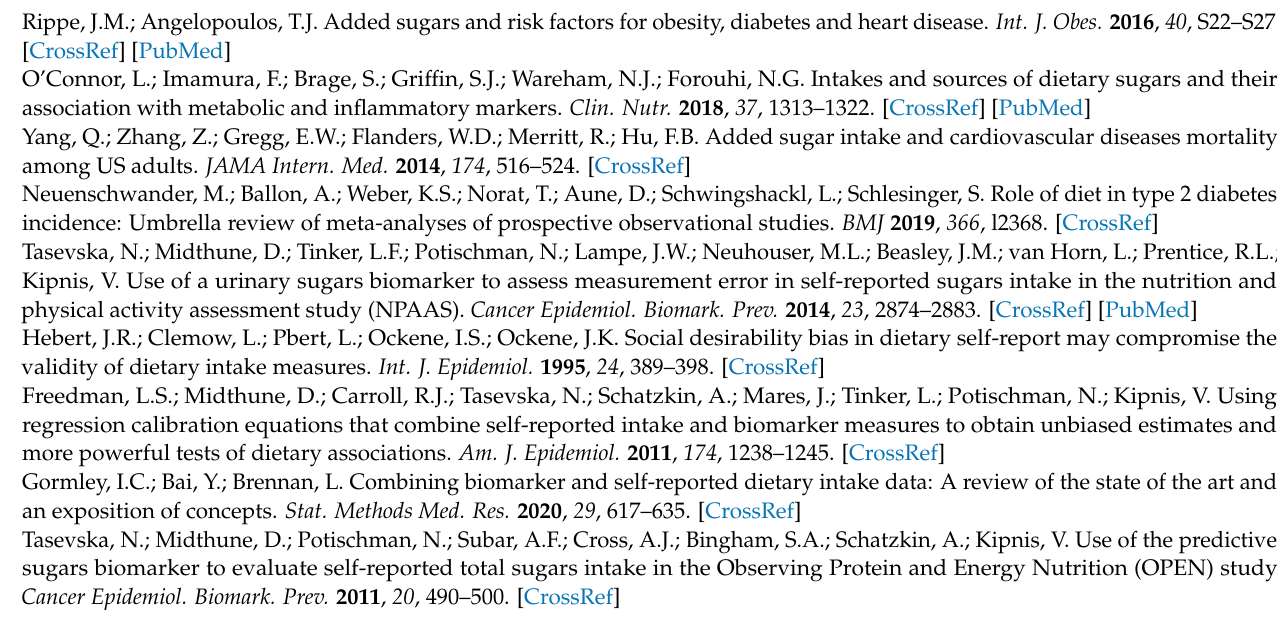
1 AS intake (g/day) and covariates were not transformed. AS, added sugars; MSPE, mean square prediction error. There was low model stability across selection approaches, as indicated by variable MSPEs across runs (Table A1) and variable numbers of covariates in the forward selection and LASSO runs. The ratio of MSPE to AS variance also varied across runs, and MSPE was often higher or nearly equal to AS variance, indicating very low predictive ability of selected models. Average MSPE did not vary greatly across the three selection